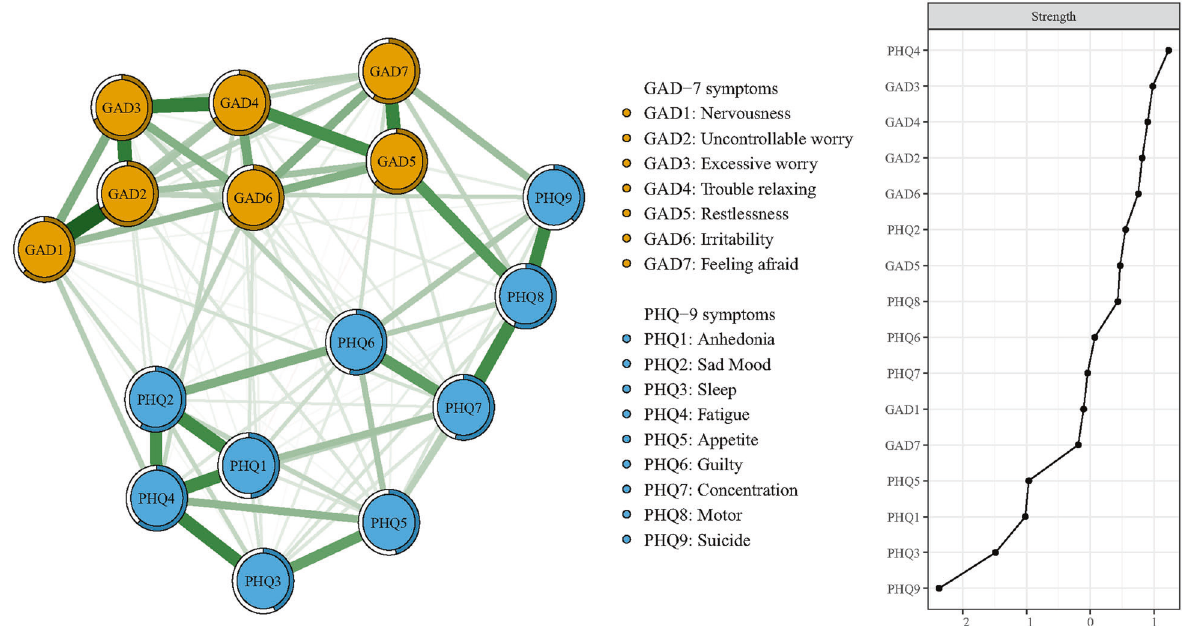
Fig. 1 Network structure of anxiety and depressive symptoms in college students. The left panel shows the visualization of the network structure; the right panel shows the value of strength in